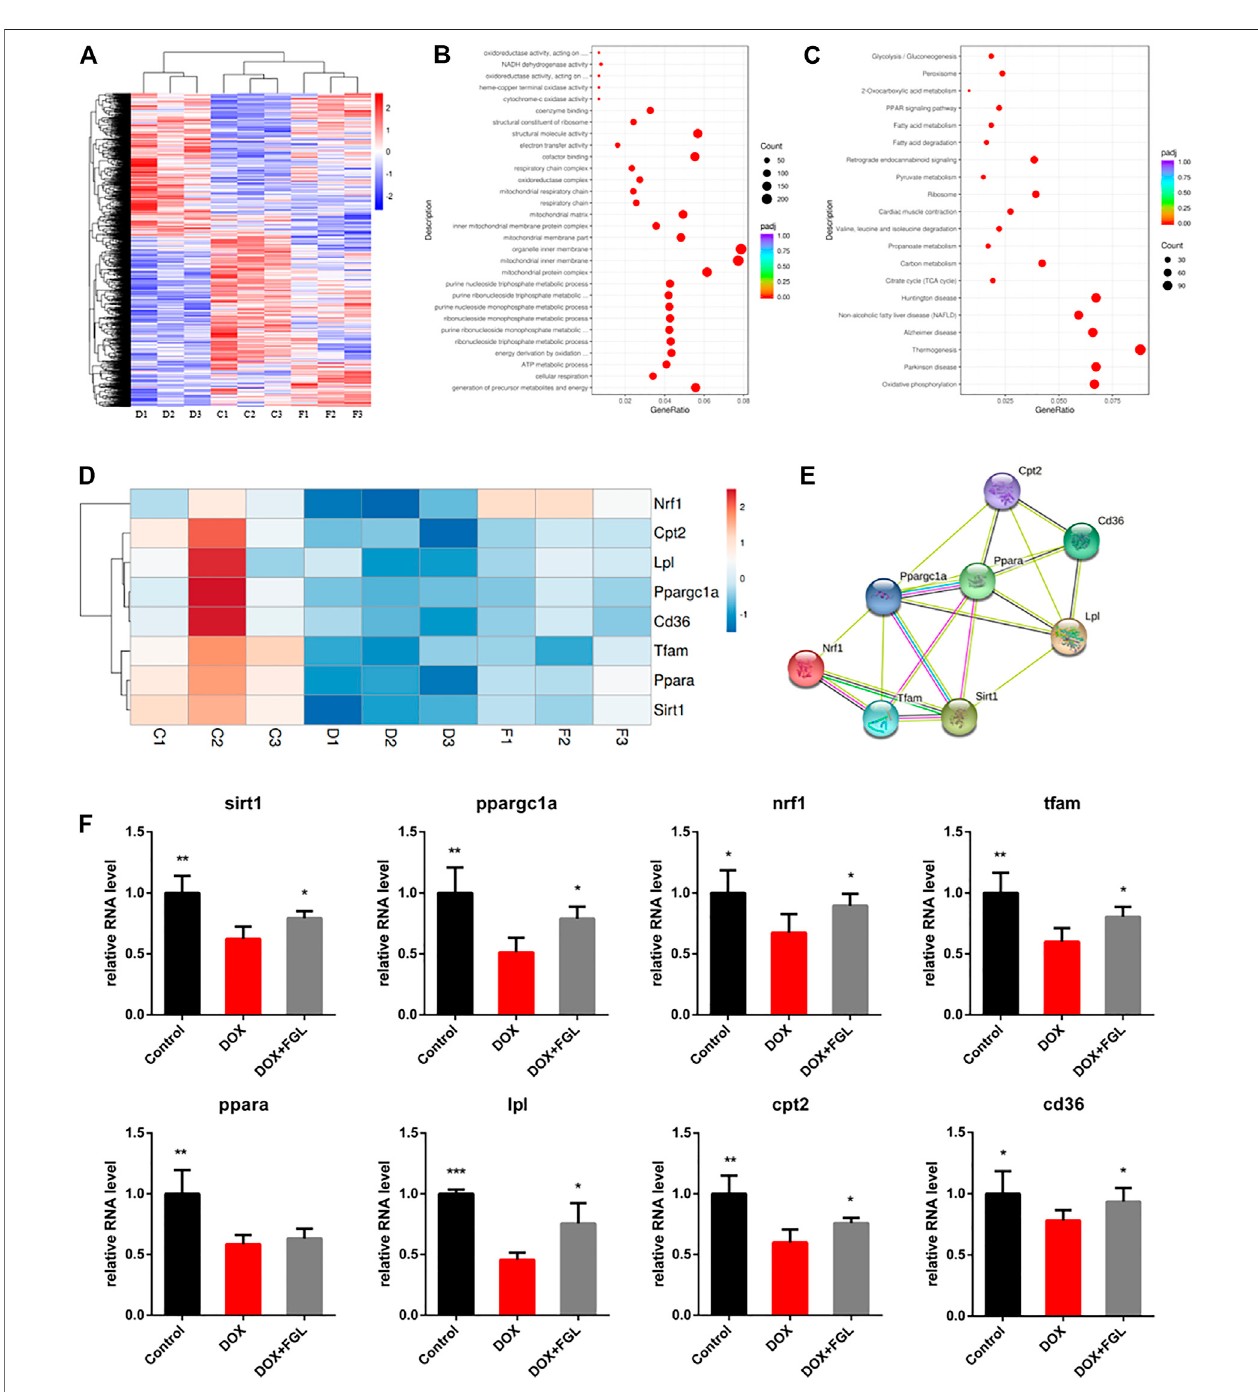
FIGURE2| The resultsofmRNAsequencingand analysis. (A) Hierarchicalclusteringofproteins andsamples. (B,C) GOand KEGG enrichment analysisbetween the control and DOX groups. (D, E) Representative gene heatmap and PPI diagram associated with MB&FAO. (F) Quantitative analysis of representative mRNA associated with MB&FAO by RT-qPCR. (n (cid:2) 3 – 5). * p < 0.05, ** p < 0.01, *** p < 0.001 vs DOX group.